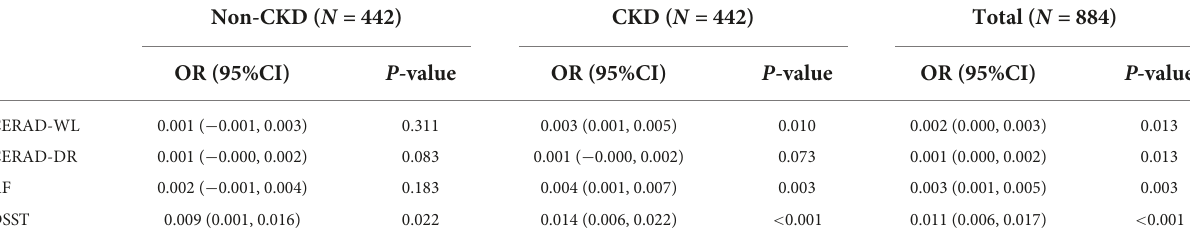
TABLE 2 Logistic regression analysis for non- chronic kidney disease (CKD) and CKD subjects between each cognitive test and caffeine intake.